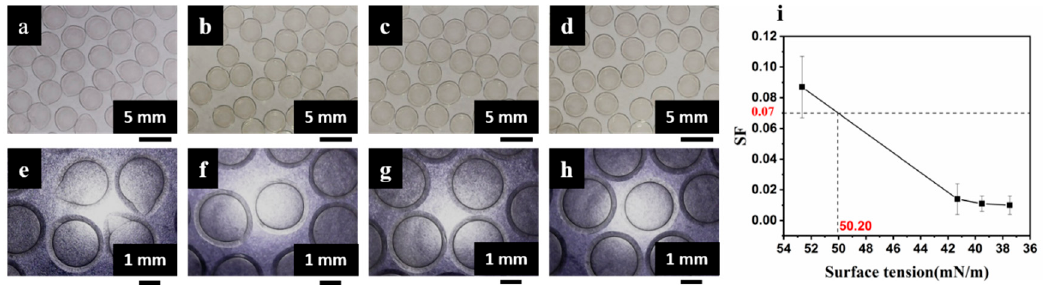
Figure 7. Images of mm-CaSA-Caps prepared with di ff erent surface tensions of SA / poloxamer 407 solution ( a ) 47.01 mN / m, ( b ) 41.71 mN / m, ( c ) 39.6 mN / m, ( d ) 37.17 mN / m; ( e – h ) are higher magnification images of ( a – d ) respectively and ( i ) SF of the mm-CaSA-Caps. The concentration of SA was 0.5 wt.%. The concentration of CaCl 2 was 1.5 wt.%. The concentration of CMC was 1.0 wt.%. The concentrations of poloxamer 407 were 0, 0.01, 0.05 and 0.2 wt.%.